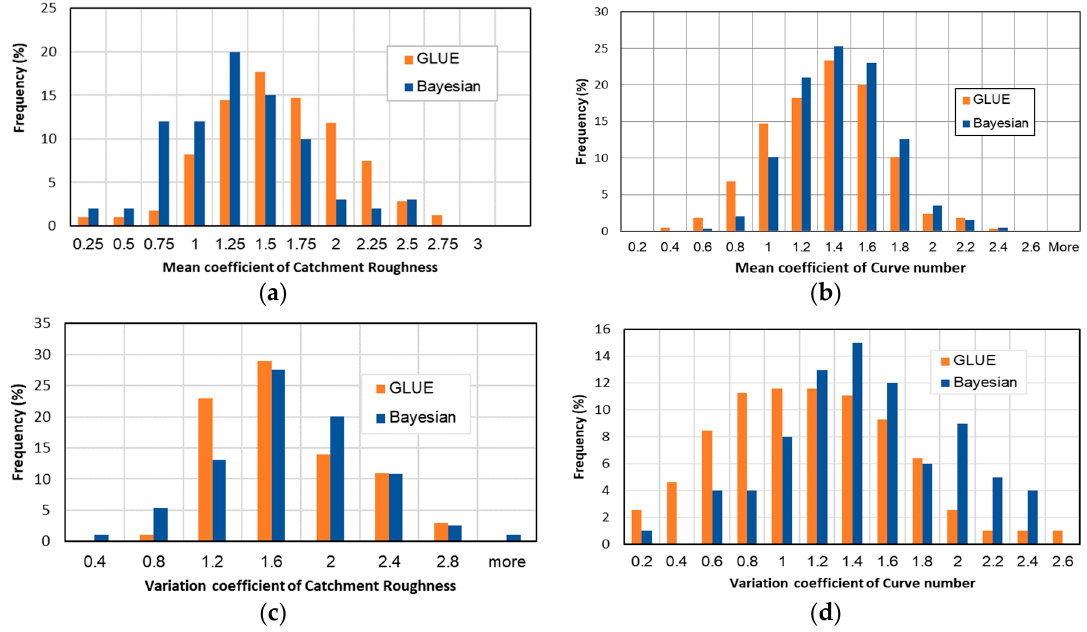
Figure 5. Histogram of mean and variation coefficients estimated by Bayesian and Generalized Likelihood Uncertainty Estimation (GLUE) method. ( a ) K 1 -catchment roughness, ( b ) K 1 —CN, ( c ) K 2 —Catchment Roughness and ( d ) K 2 —CN .